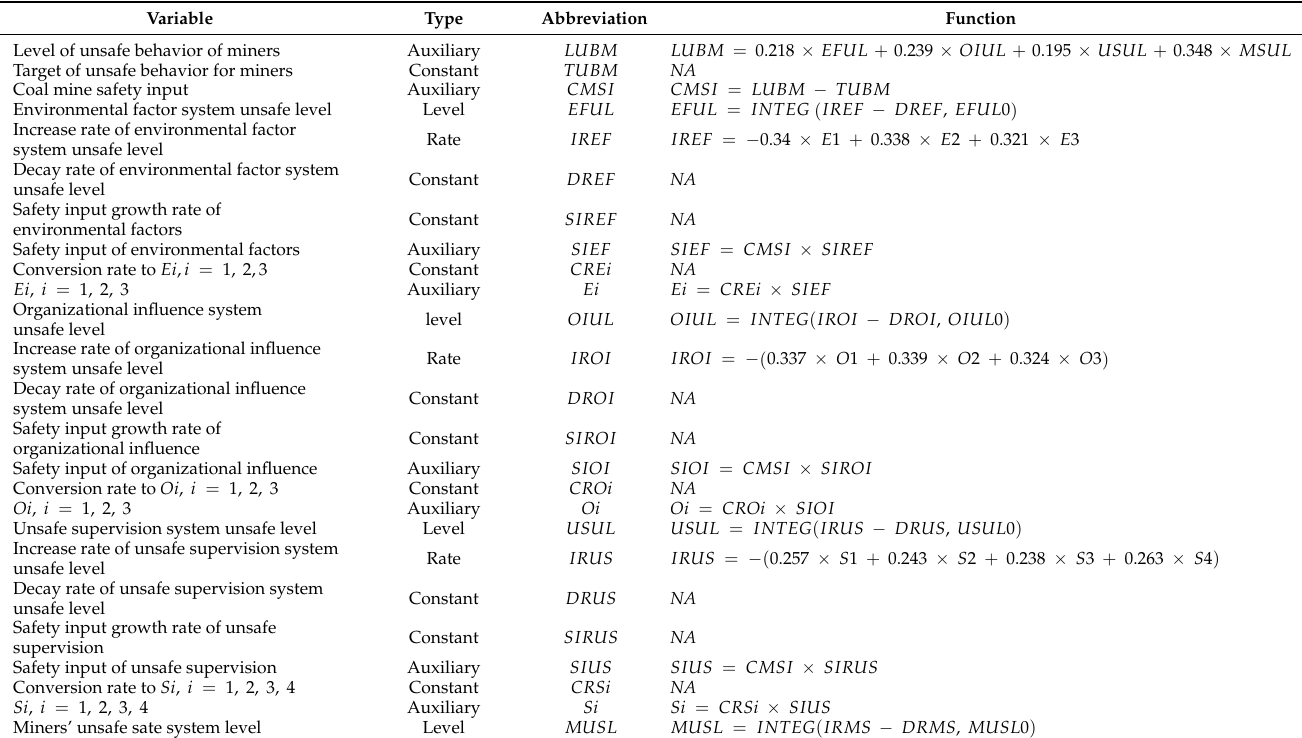
Figure 6. Inventory flow chart for the management of unsafe mining behaviors. Table 9. Variables and functions in the SD